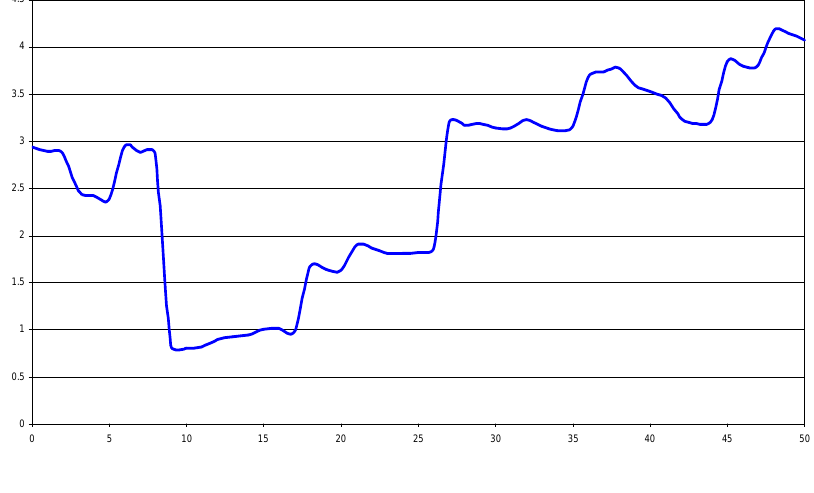
Figure 7. Dynamics of the financial stability index of JSC